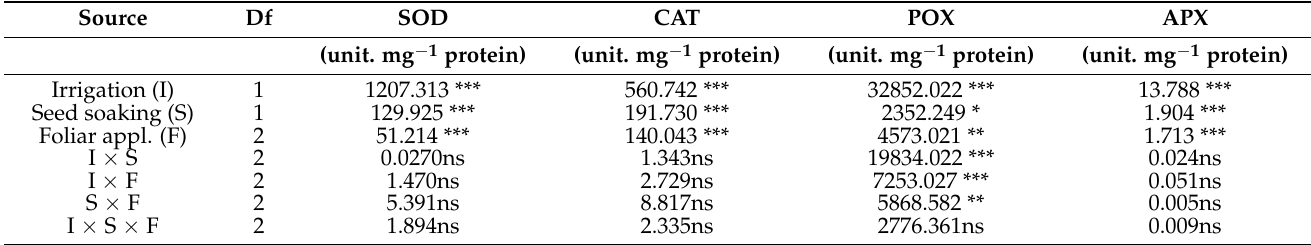
Table 5. Analysis of variance (mean square) of antioxidant enzymes.